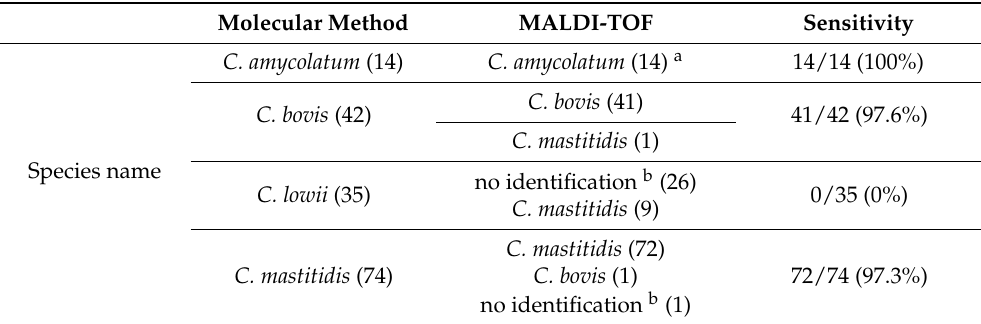
Table 3. Comparison of results of MALDI-TOF MS with molecular methods for identifying Corynebacterium